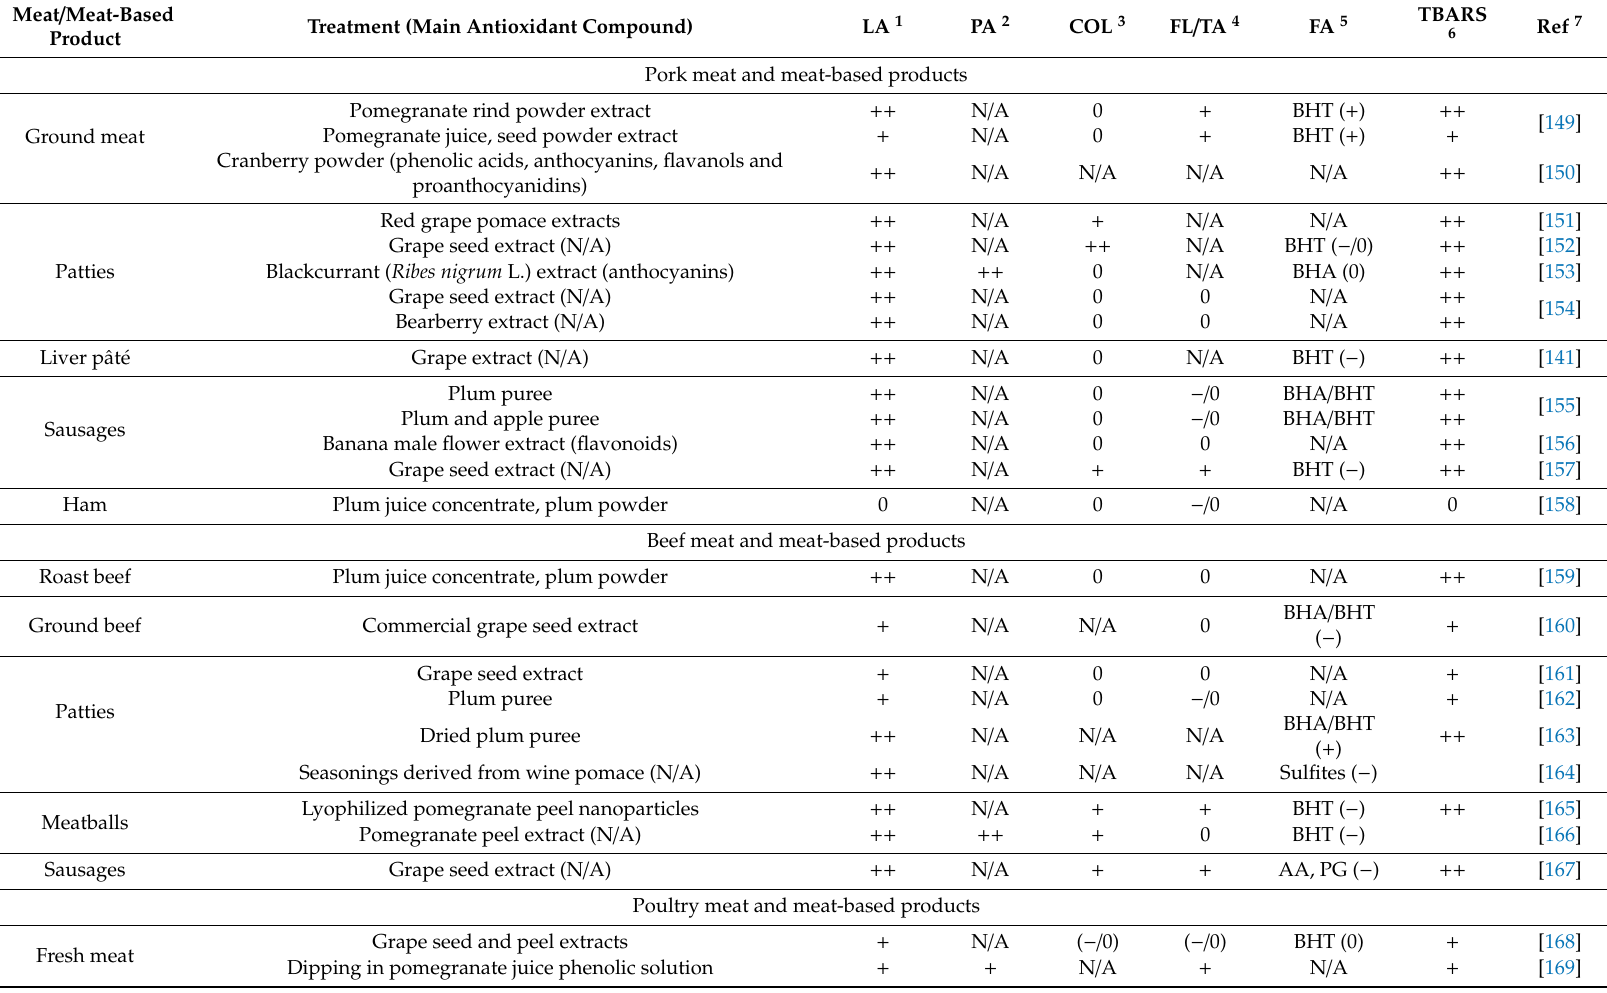
Table 2. E ff ects of fruit-derived antioxidant compounds in meat and meat-based